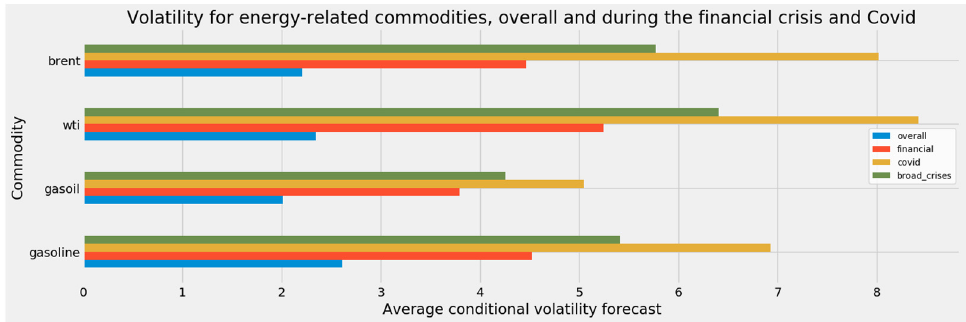
Figure 46. Volatility for energy-related commodities, overall and during the financial crisis and the pandemic.